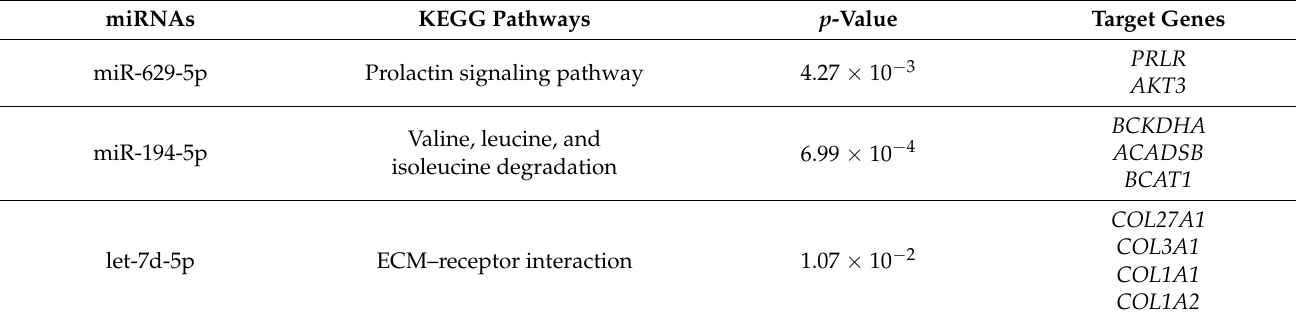
Figure 5. miRNAs expression in the serum from PCa patients stratified according to tumor staging. ( A – D ) Boxplot showing the expression of ( A ) mir-629-5p, ( B ) mir-374-5p, ( C ) mir-194-5p, and ( D ) let-7d-5p in the serum from control healthy volunteers ( n = 41) and human PCa patients from the GSE112264 dataset, stratified according to tumor staging (T1 = 256 samples, T2 = 354 samples, T3 = 183 samples, T4 stage = 16 samples). Shown in the boxplot are the medians (horizontal lines), 25th–75th percentiles (box outlines), and the highest and lowest values within 1.5 × of the inter-quartile range (vertical lines). Samples from each tumor stage were compared to control healthy samples by using the two-tailed Mann–Whitney U-test. *, p -value < 0.05; ** p -value < 0.01; *** p -value < 0.001; **** p -value < 0.0001. Statistical significance for multiple comparisons was calculated by using the Kruskal–Wallis test. p -value < 0.0001 ( A , B , D ); p -value = 0.0146 ( C ). Table 1. Enrichment analysis of putative miRNA–gene interactions followed by targeted pathway